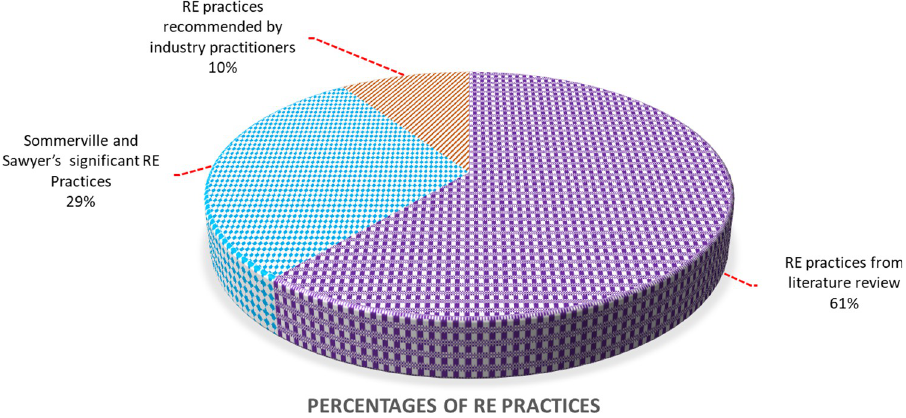
Fig 5. Percentages of RE practices from various